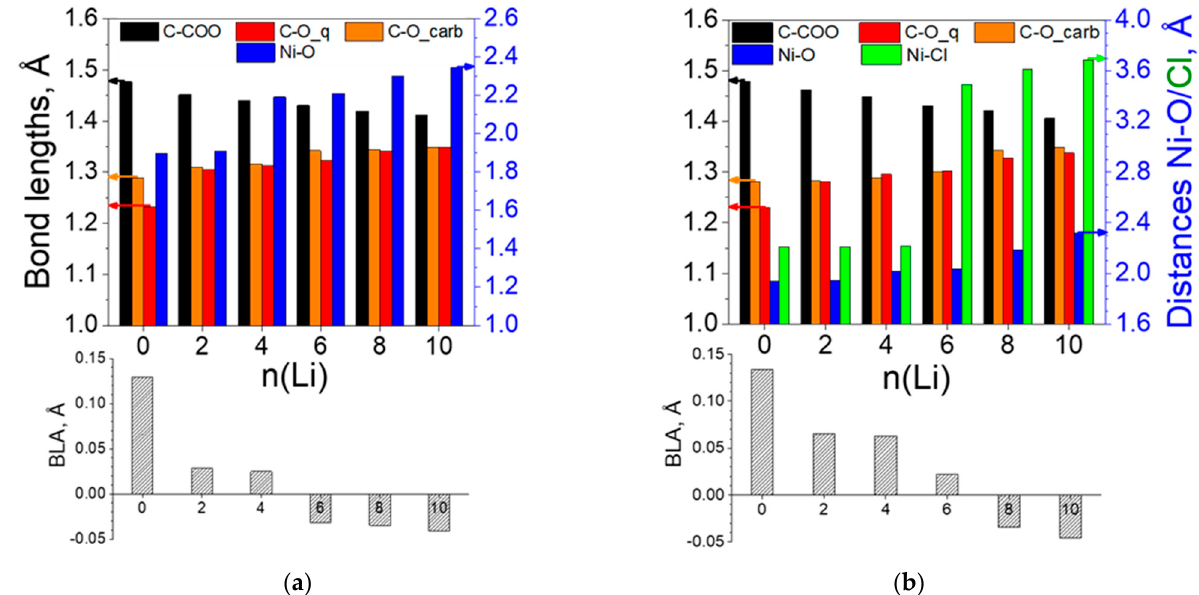
Figure 8. Variation in the averaged bond lengths and BLA of ( a ) [Ni(II)L2] n and ( b ) [Ni(IV)L2] n . Arrows instruct which axis corresponds to the values of the structural parameters. Numerical quantities can be found in Tables S6 and S7.